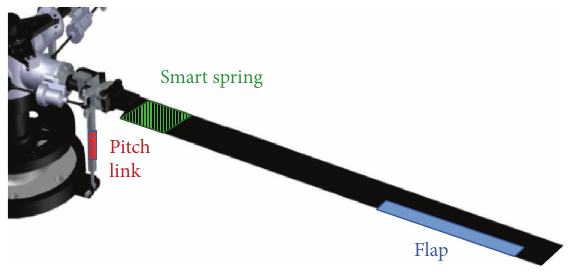
variation and flap deflection are obtained by an optimal control based on the minimization of a cost function which includes hub loads and control input harmonics, under the constraint of compatibility with equations governing the blade